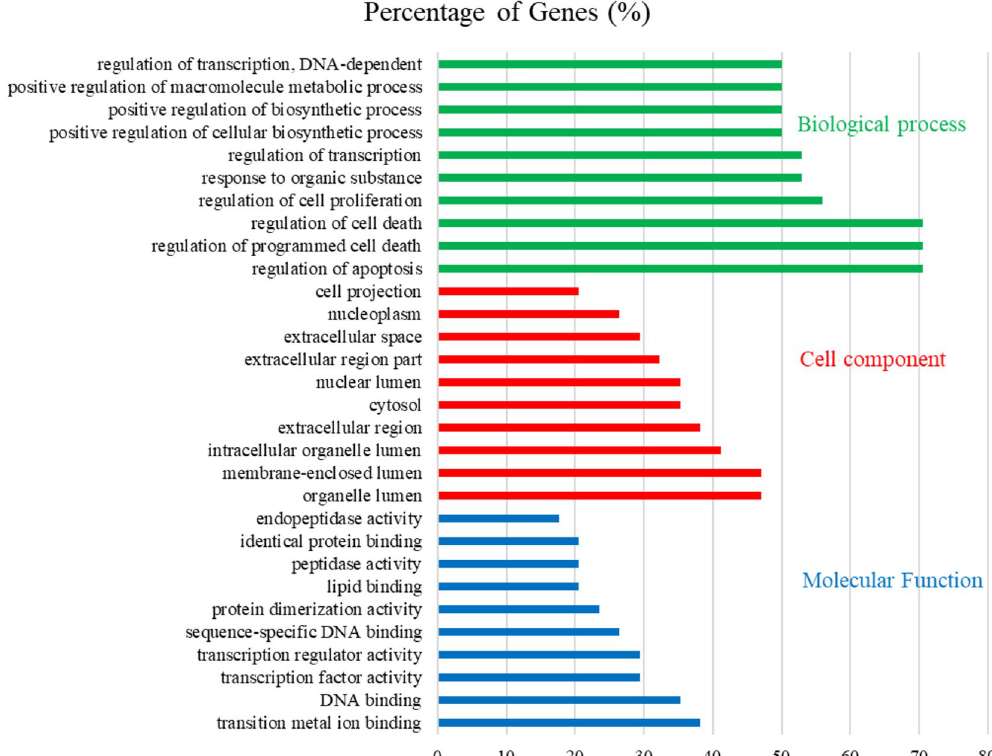
Figure 8. Gene Ontology (GO) analysis of targets of Banxia-Xiakucao Chinese Herb Pair: 34 core candidate targets of BXHP were analyzed. Enrichment results were obtained for biological processes, cell components, and molecular functions; only the top 10 GO terms with P < 0.05 are displayed for each category. The terms for each category are presented in ascending order of the percentage of